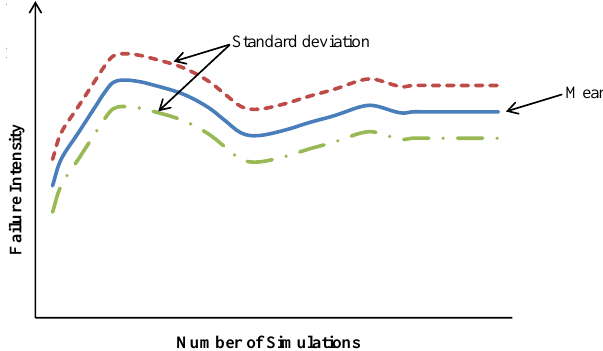
Figure 1. Typical relation between failure intensity and number of simulations in typical Monte Carlo simulation